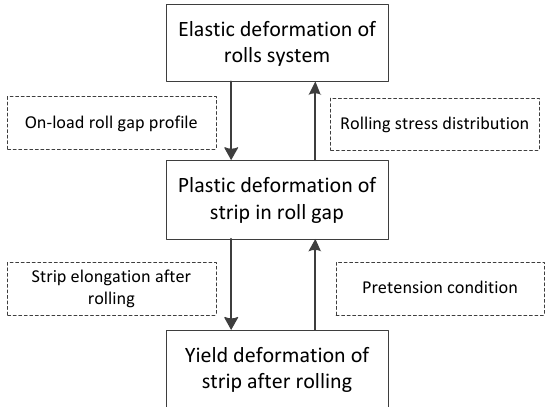
Figure 2. Roll and strip influence on each other during and after rolling.